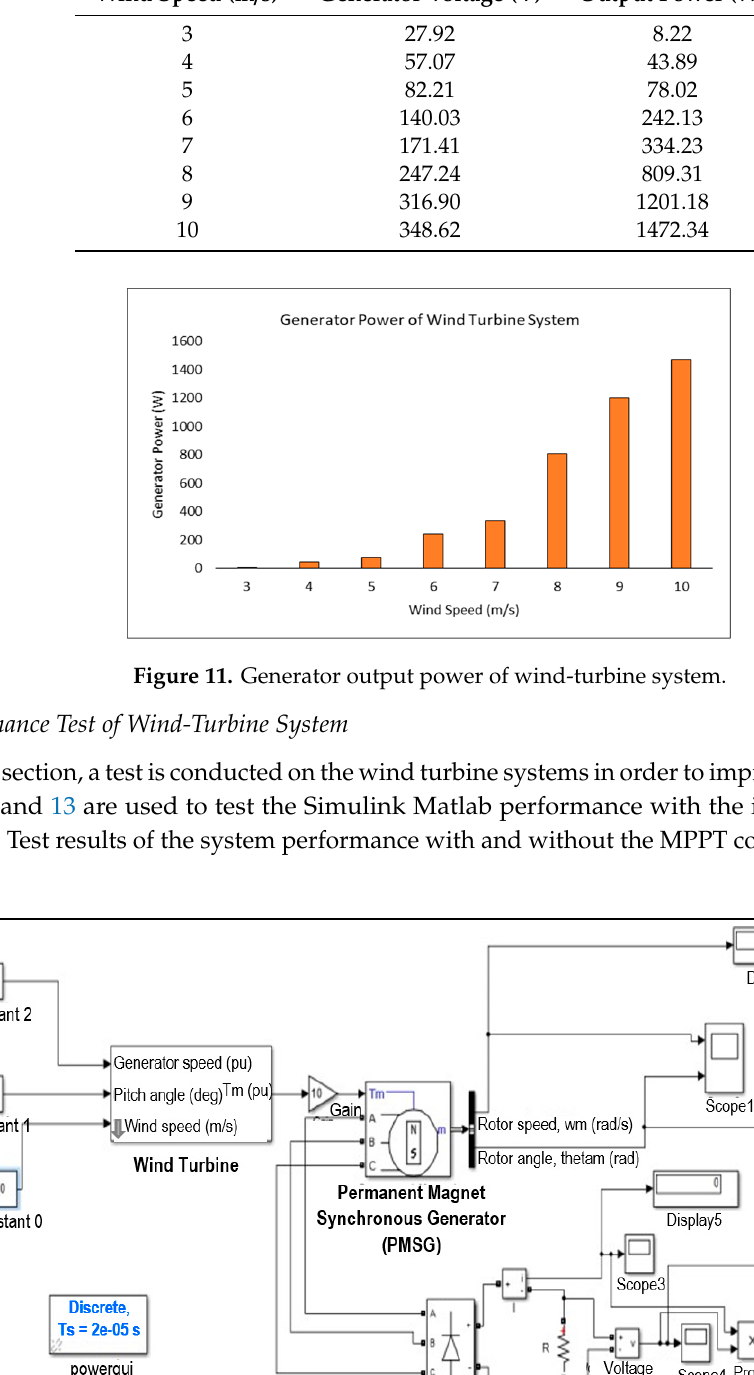
Figure 13. Wind-turbine system with MPPT in Simulink-Matlab software.